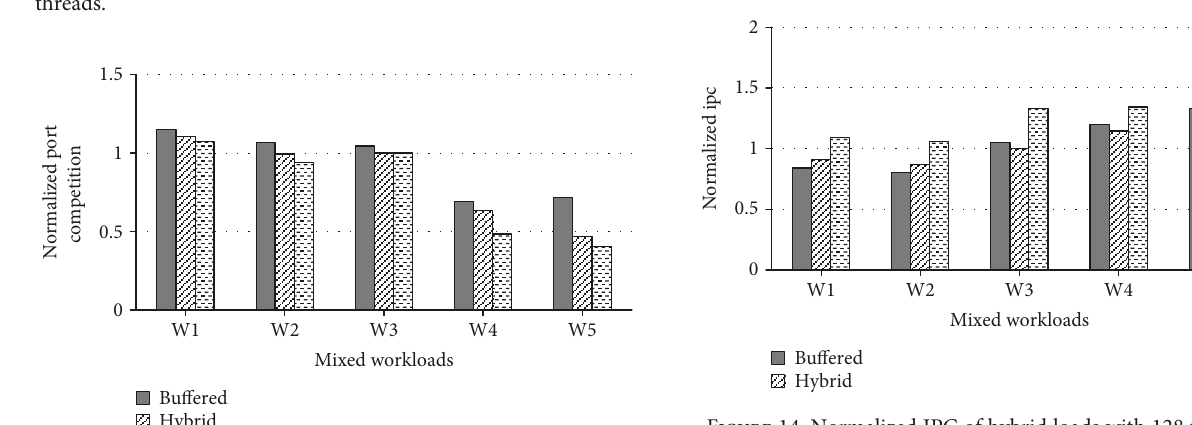
Figure 14: Normalized IPC of hybrid loads with 128